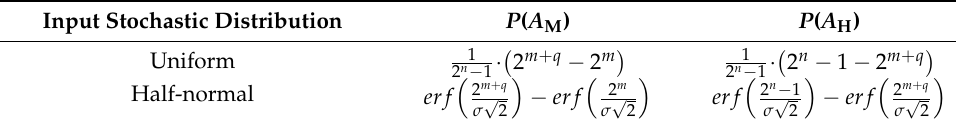
Table 3. Probability of selecting A M and A H as a function of the input distribution.